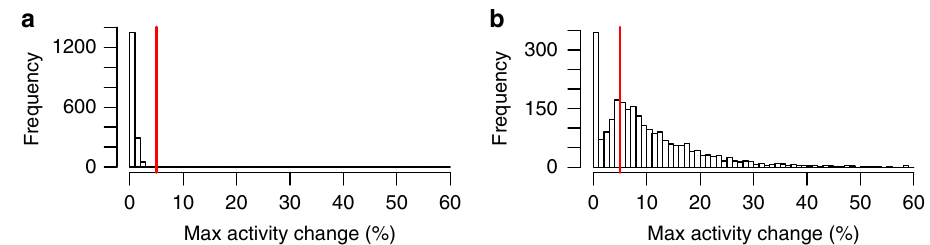
Fig. 5 Maximum signature activity changes in PCAWG samples. The red line shows the threshold of 5%, above which we consider changes to be signi fi cant. a Changes on random orders of mutations where we do not expect to see change in activities. b activity changes in TrackSig trajectories across all samples (on mutations sorted by CCF). Frequency axis shows the number of samples where we observe the certain